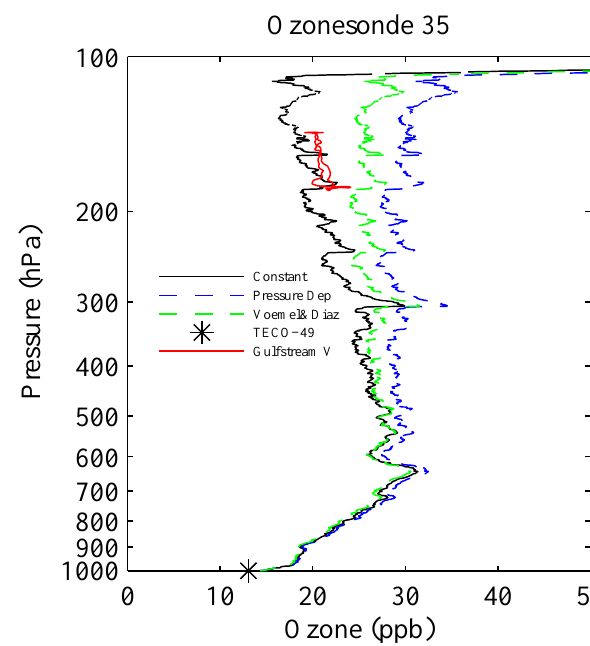
Figure 5. As Fig. 4 for CAST ozonesonde 34 and outbound leg of Gulfstream V flight RF14 on 22 February.